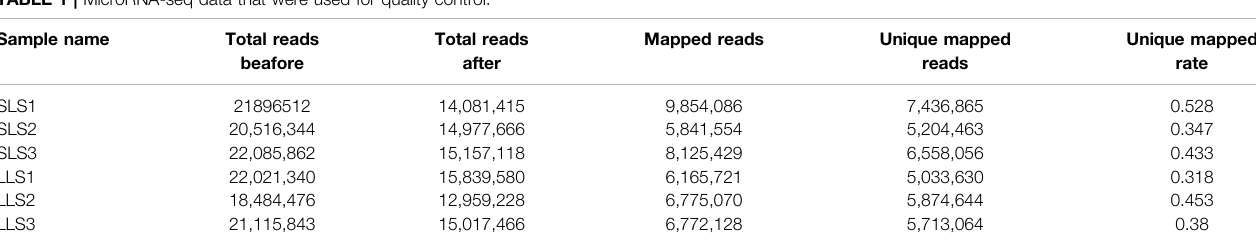
TABLE 1 | MicroRNA-seq data that were used for quality